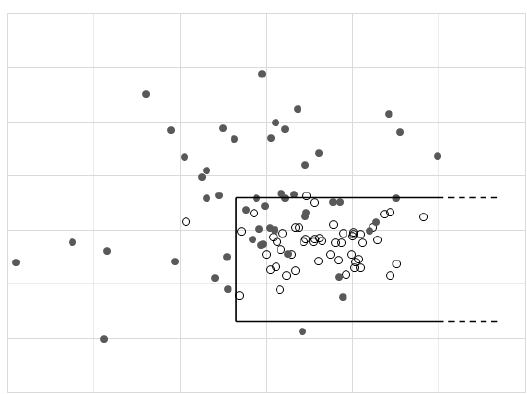
Figure 9. Combination of two metrics using a single (open) rectangle to discriminate between Positive (white) and Negative (black) classification.